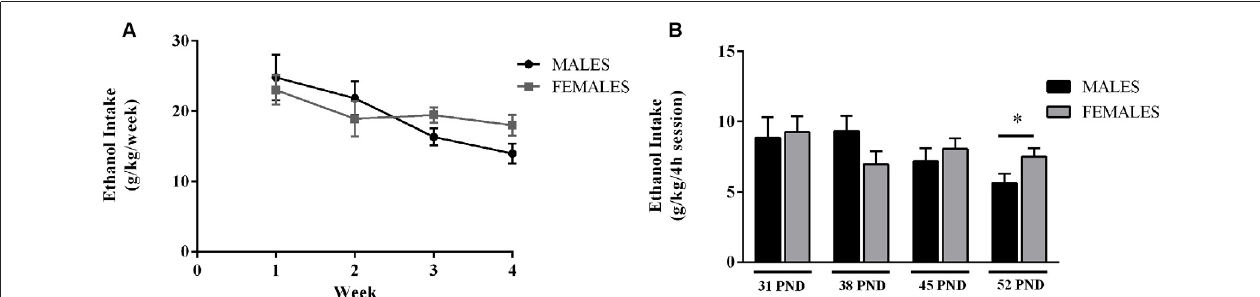
Frontiers in Behavioral Neuroscience |